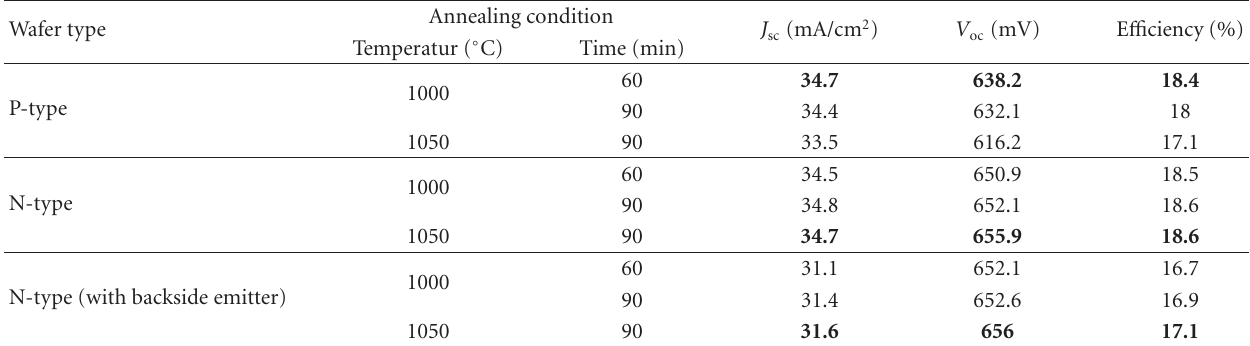
Table 1: Results of PC1D simulation using data in this